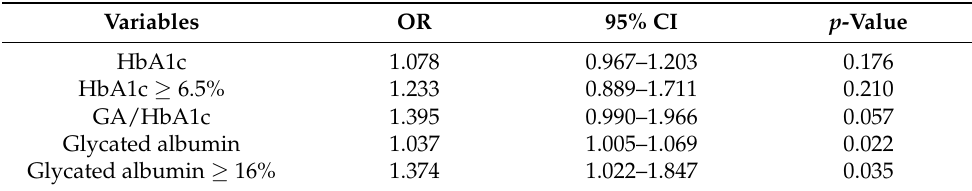
Table 4. Effect of glycemic control parameters on unfavorable short-term outcomes (compared to favorable 3-month mRS 0–2).